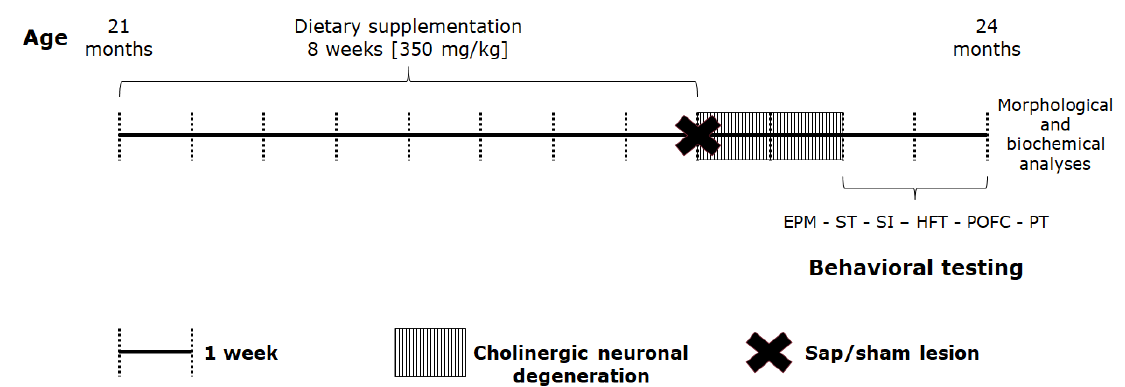
Figure 1. Experimental procedures. After 8-week oral supplementation with n-3 PUFA, 21-month old aged mice have been subjected to intracerebroventricular (i.c.v.) injections of mu-p75-saporin or saline (sham lesion) to selectively deplete the forebrain cholinergic system. Two weeks after the lesion, the animals were behaviorally tested by means of validated tasks (Elevated Plus Maze, EPM; Splash Test, ST; Social Interactions, SI; Hidden Food Test, HFT; Predator Odor Fear Conditioning, POFC; Porsolt Test, PT). At the end of testing battery, mice were sacrificed, and brains collected for morphological and biochemical